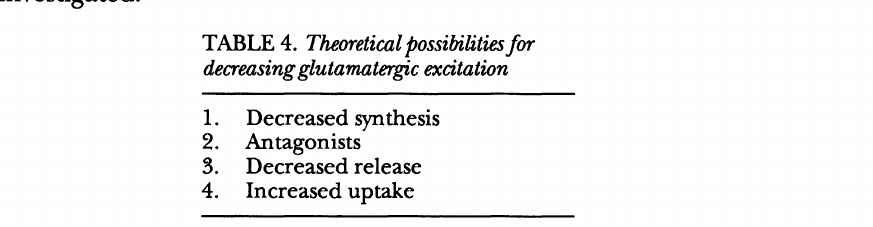
TABLE 4. Theoretical possibilities for decreasing glutamatergic